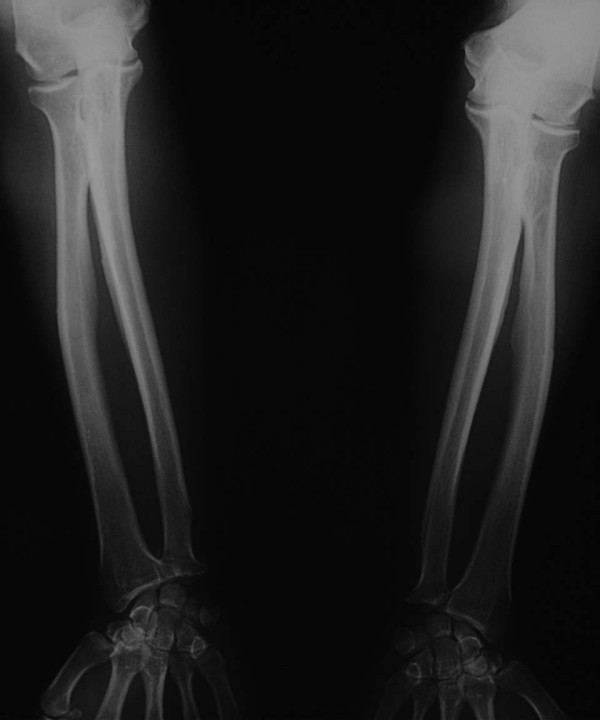
Anteroposterior view radiograph of both forearms showed significant calcifications of interosseous membranes of forearm.